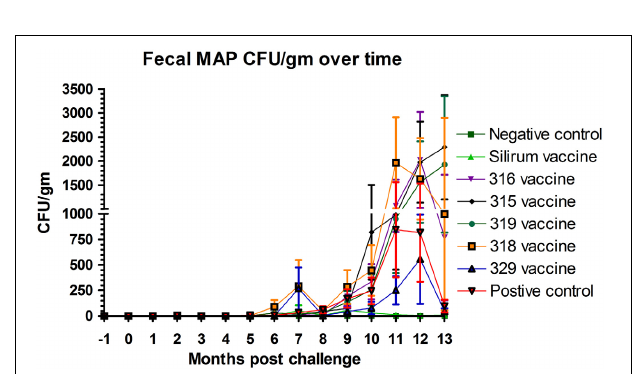
FIGURE 3 | Monthly fecal culture results on Herrold’s Egg Yolk medium with and without mycobactin J throughout the study. No positive samples were detected in the non-challenged control group. (Error bars represent standard error of the mean, − 1 is baseline bleeding, 0 is challenge date and 1–13 represents months